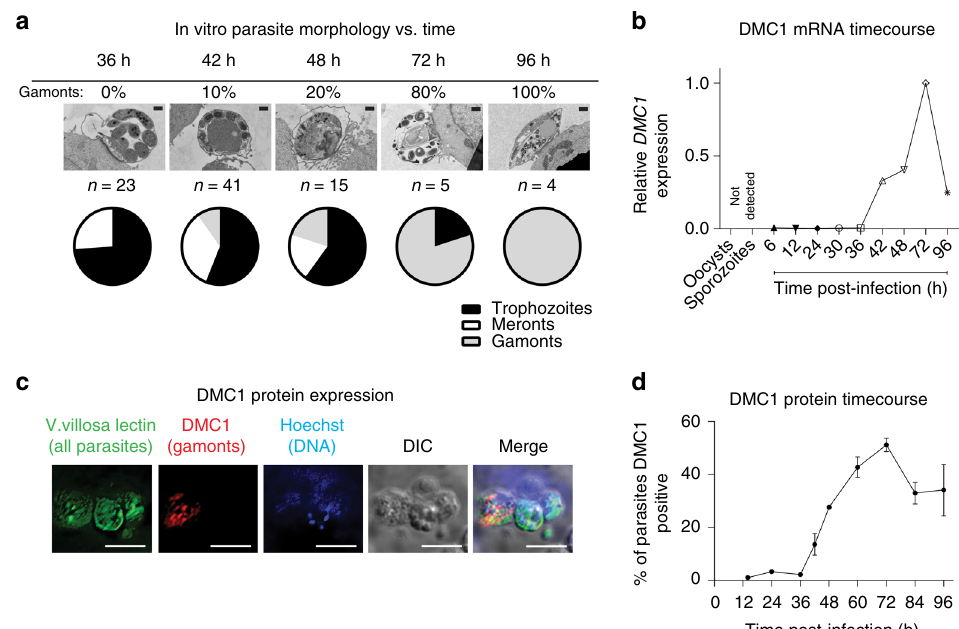
Fig. 5 DNA Meiotic Recombinase 1 (DMC1) is a biomarker for C. parvum sexual development. a Representative transmission electron microscopy (TEM) images and results of scoring the relative abundance of different C. parvum life cycle stages present versus time after infection of host cell monolayers. Con fl uent HCT-8 cells were infected with C. parvum for the indicated times before preparing samples for TEM. Scale bar = 500 nm. b C. parvum DMC1 mRNA versus time during HCT-8 cell infection. Wells from the same culture plate as in a were used to isolate RNA, and quantitative reverse transcription PCR (qRT-PCR) was used to measure expression of C. parvum DMC1 (cgd7_1690) relative to 18s RNA. Data for a and b are representative of